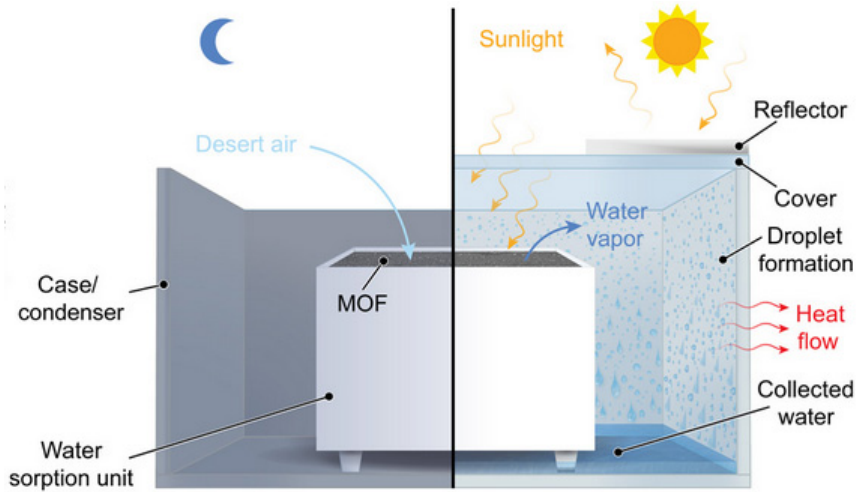
Figure 3. Desiccant-based AWG scheme, image adapted from [22].